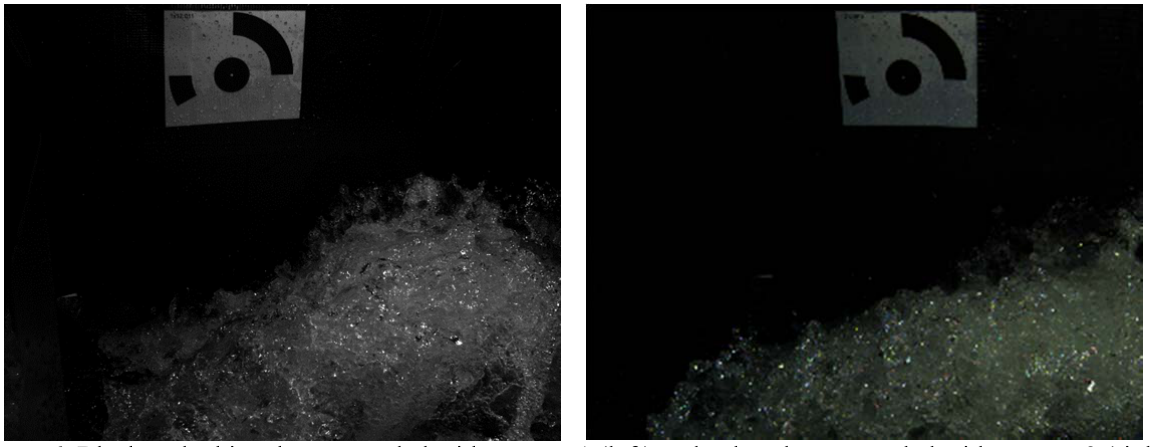
Figure 6. Black and white photo recorded with camera 1 (left) and color photo recorded with camera 2